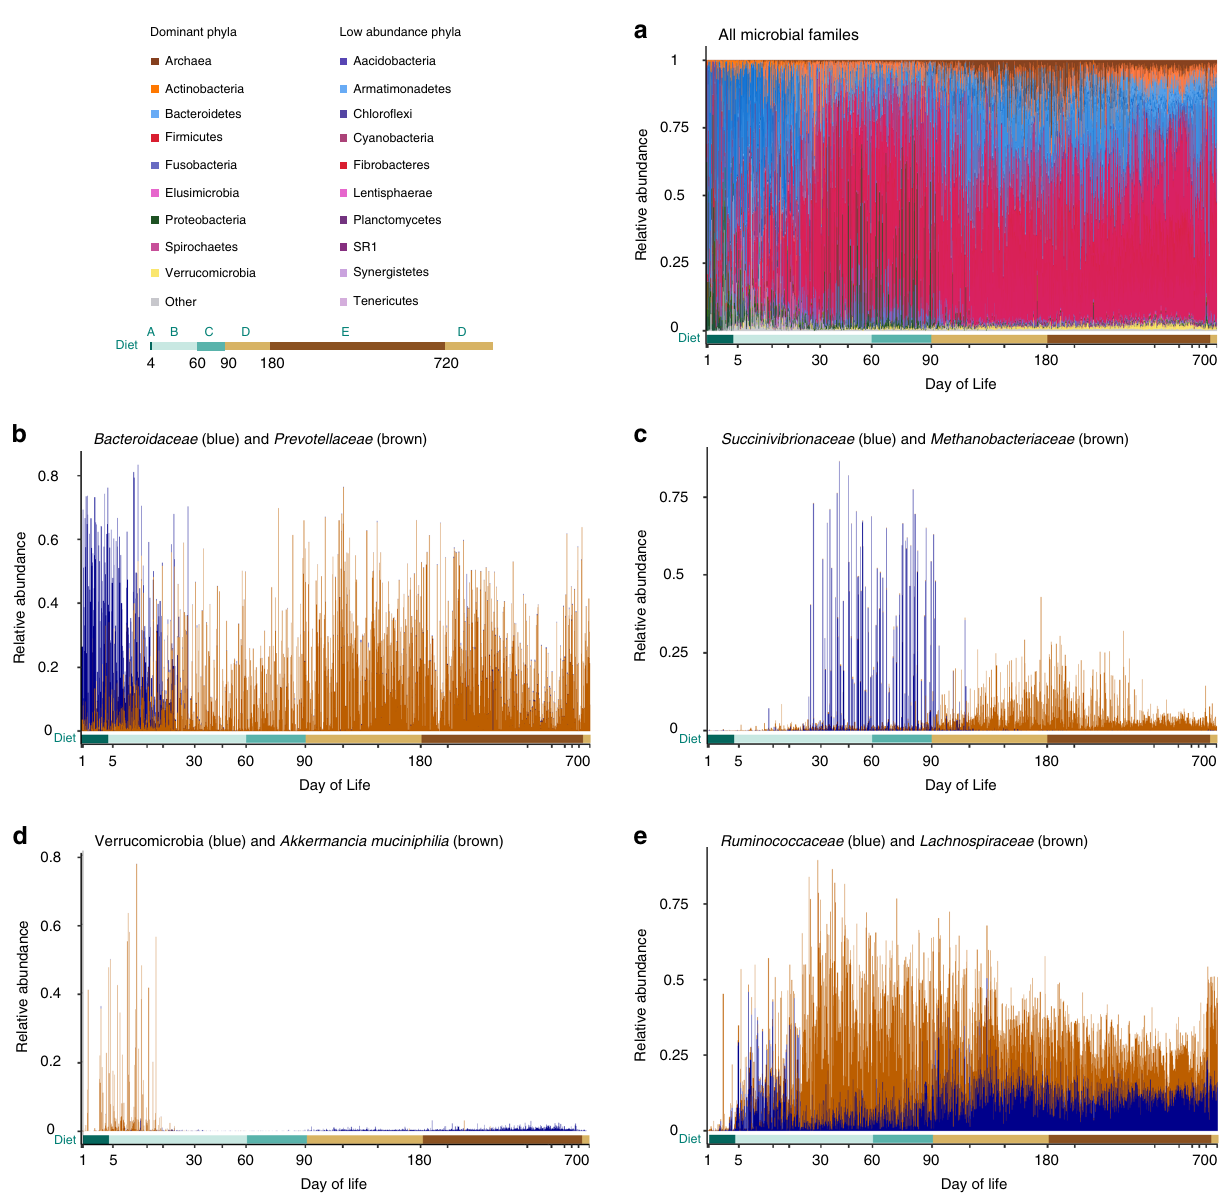
Fig. 2 Dynamics of the different microbial families is shaped by age and diet. a Relative abundance of 291 microbial families. All families belonging to the